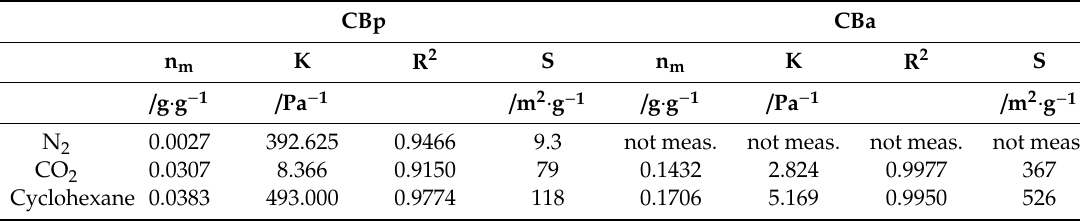
Table 4. Parameters of the Langmuir isotherm with the coe ffi cient of determination at 20 ◦ C for N 2 and CO 2 and at 30 ◦ C for cyclohexane.